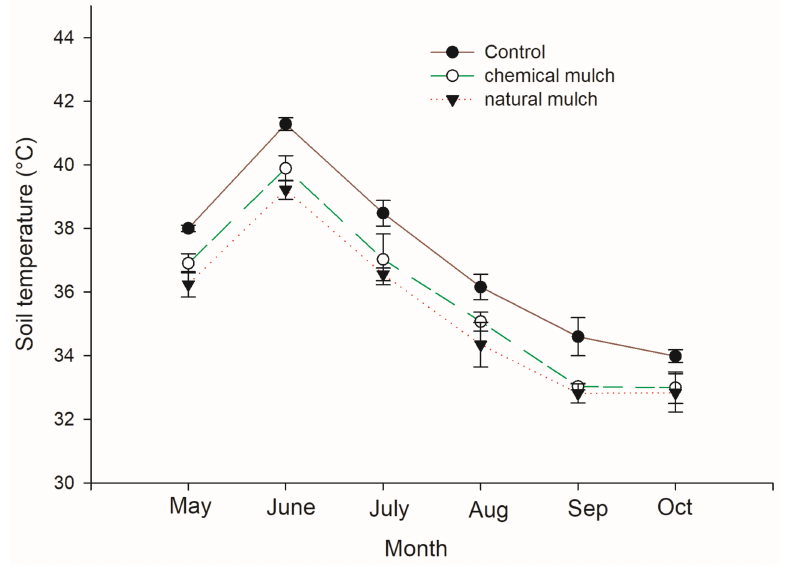
Figure 2. Impact of mulch on soil temperature during crop growing season during 2018–2019.